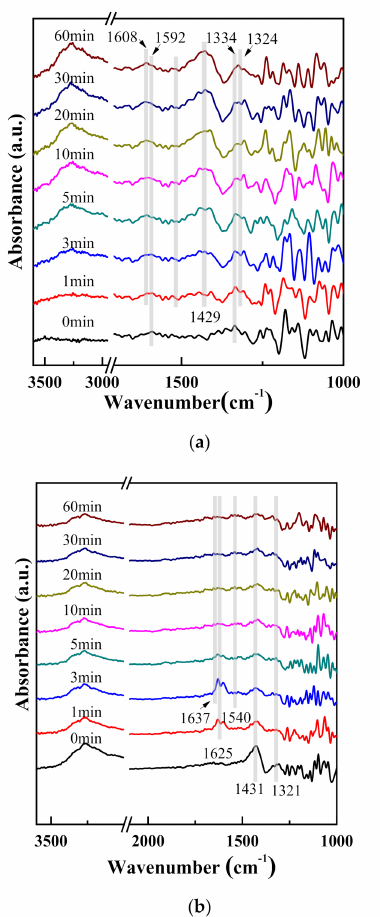
Figure 9. In situ DRIFT spectra of ( a ) NH 3 reacted with preadsorbed NO + O 2 and ( b ) NO + O 2 reacted with preadsorbed NH 3 on S (Fe /